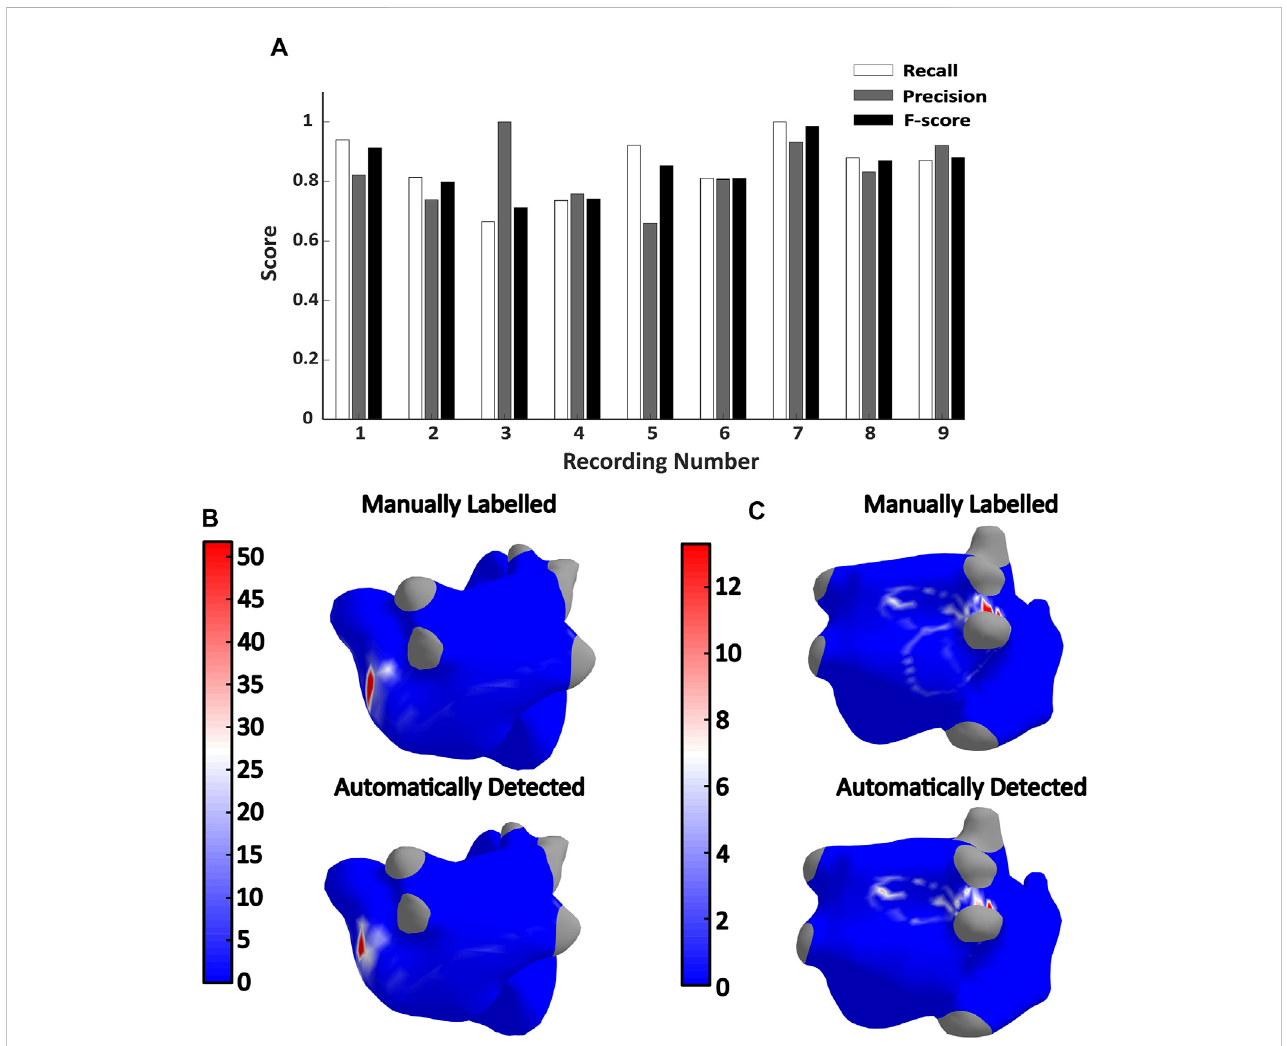
FIGURE 2 (A) Recall, precision and F-score values obtained inthevalidation dataset. (B,C) , Manually labelled and automaticallydetected rotor histograms obtained from recordings 9 (top) and 3 (bottom) respectively. The recall, precision and F-score values calculated in recording 9 were 0.87, 0.92, and 0.87 while the recall, precision and F-score values of recording 3 are 0.66, 1, and 0.7